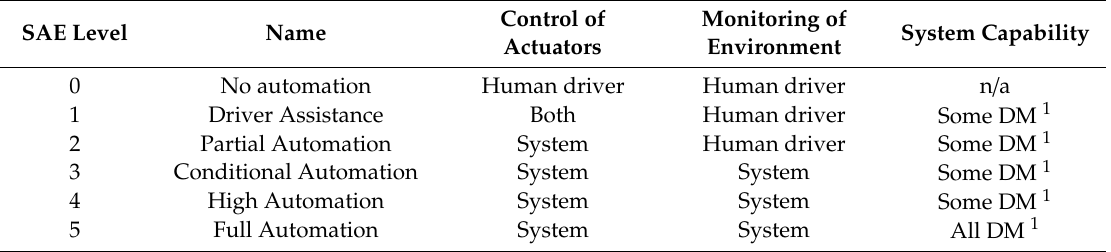
Table 1. Levels of automated driving for road vehicles defined by the Society of Automotive Engineers